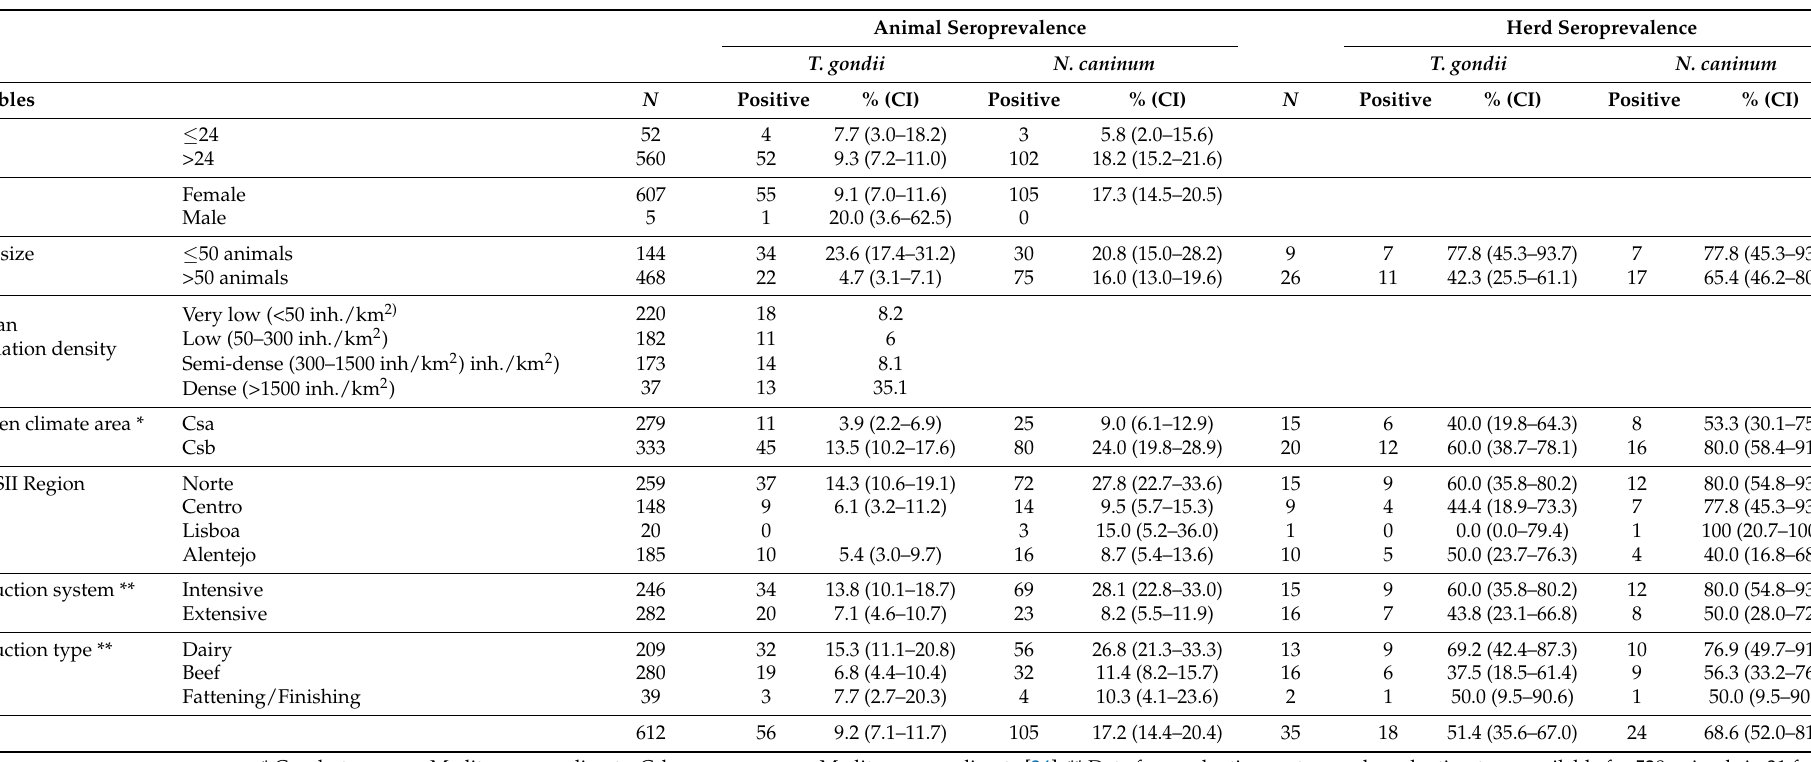
Table 1. Animal and herd seroprevalence (%) of Toxoplasma gondii and Neospora caninum in cattle in Portugal according to age, sex, herd size, human population density, Köppen climate area, NUTSII regions, production system, and production type. (CI) Confidence Interval for